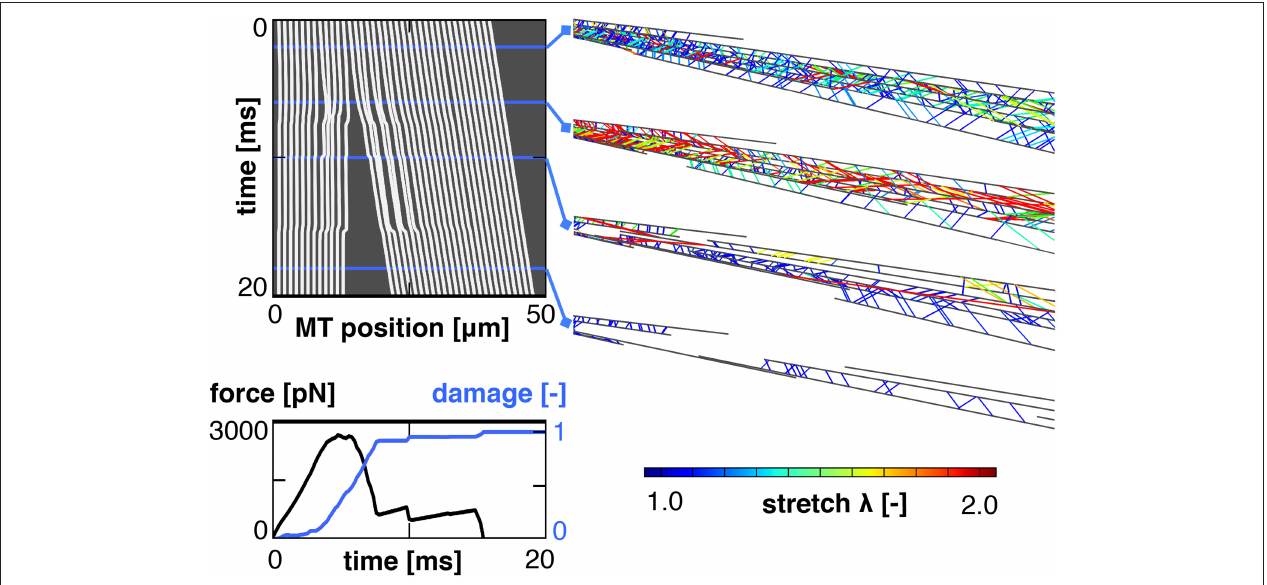
FIGURE 5 | Characteristic output of a single simulation. The kymograph, (Top left) , tracks the position of all microtubules throughout the simulation. It reveals a complete separation between the proximal and distal ends of the axon. This separation manifests itself in a loss of the required external force and an increase in axonal damage (Bottom left) . Four snapshots of the axon show the crosslinks color coded by crosslink stretch (Right) . These snapshots show an initial increase in crosslink stretch, followed by a decrease after the proximal and distal sets of microtubule bundles have